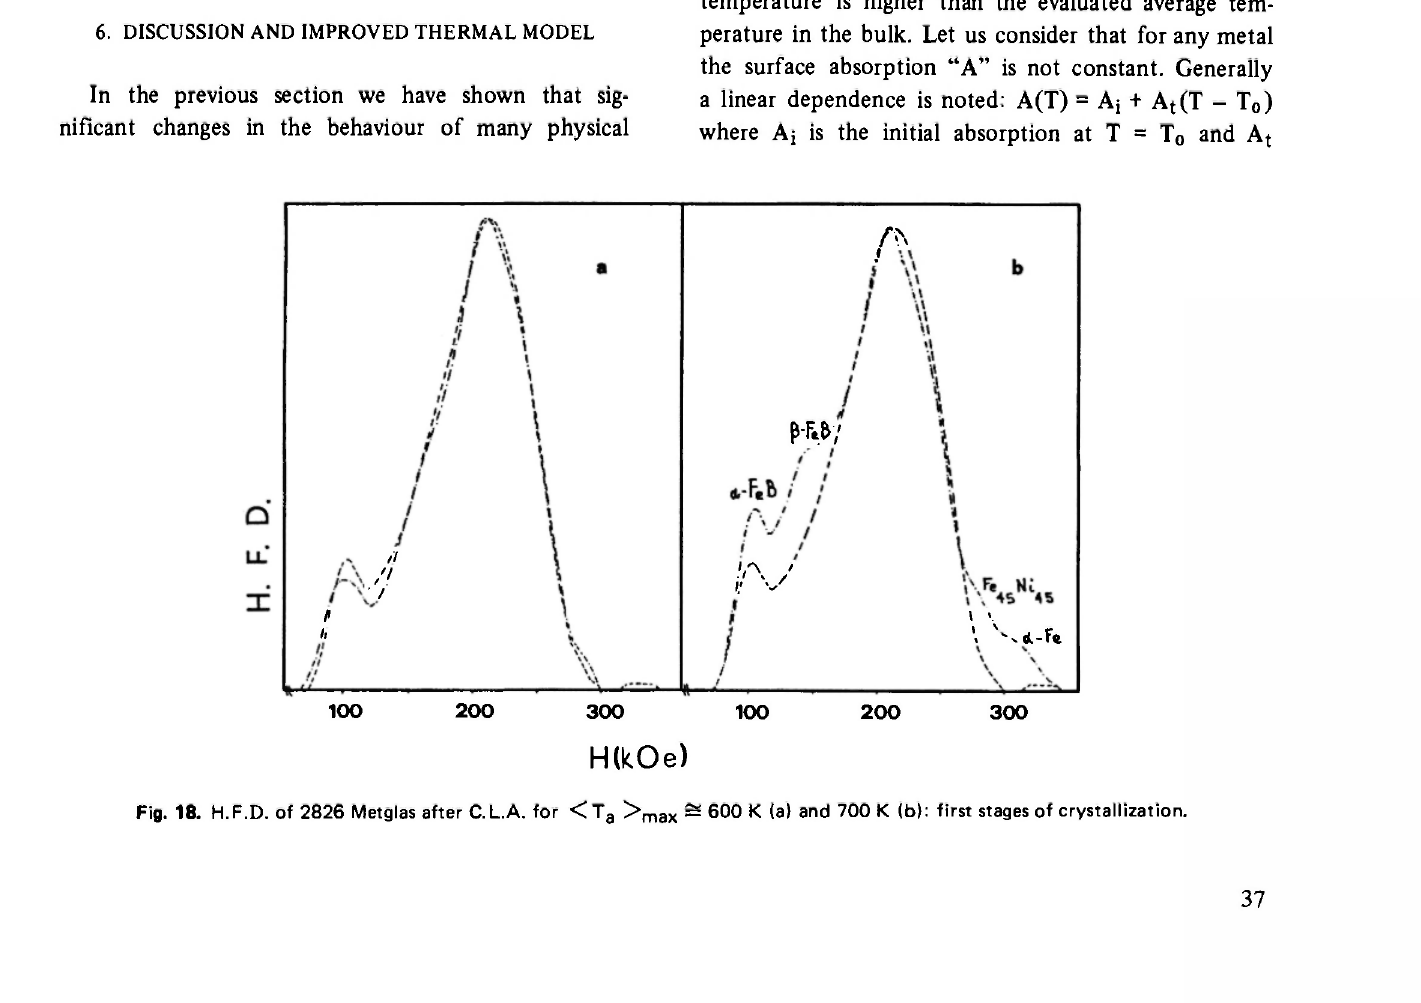
Fig. 17. Improvement of the magnetoelastic coupling factor due to C.L.A. when < T a > m ax is below 400-500 K, and evidence of its decrease for increasing temperature values.